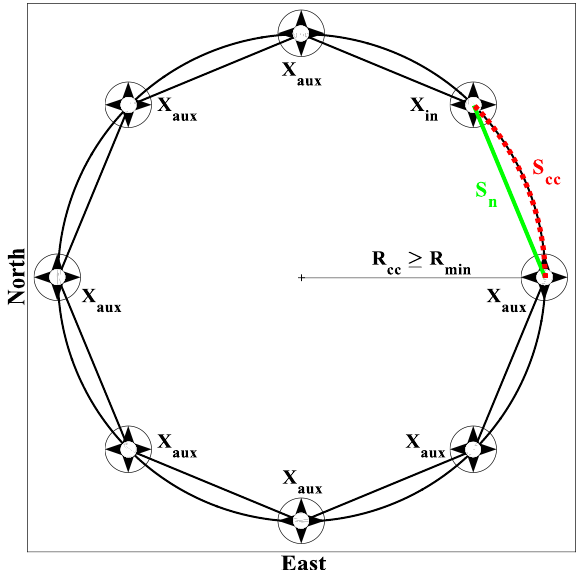
Figure 8. Circular holding pattern defined by eight fly-over